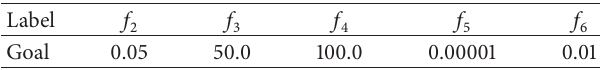
Table 3: Goals for the test problems in